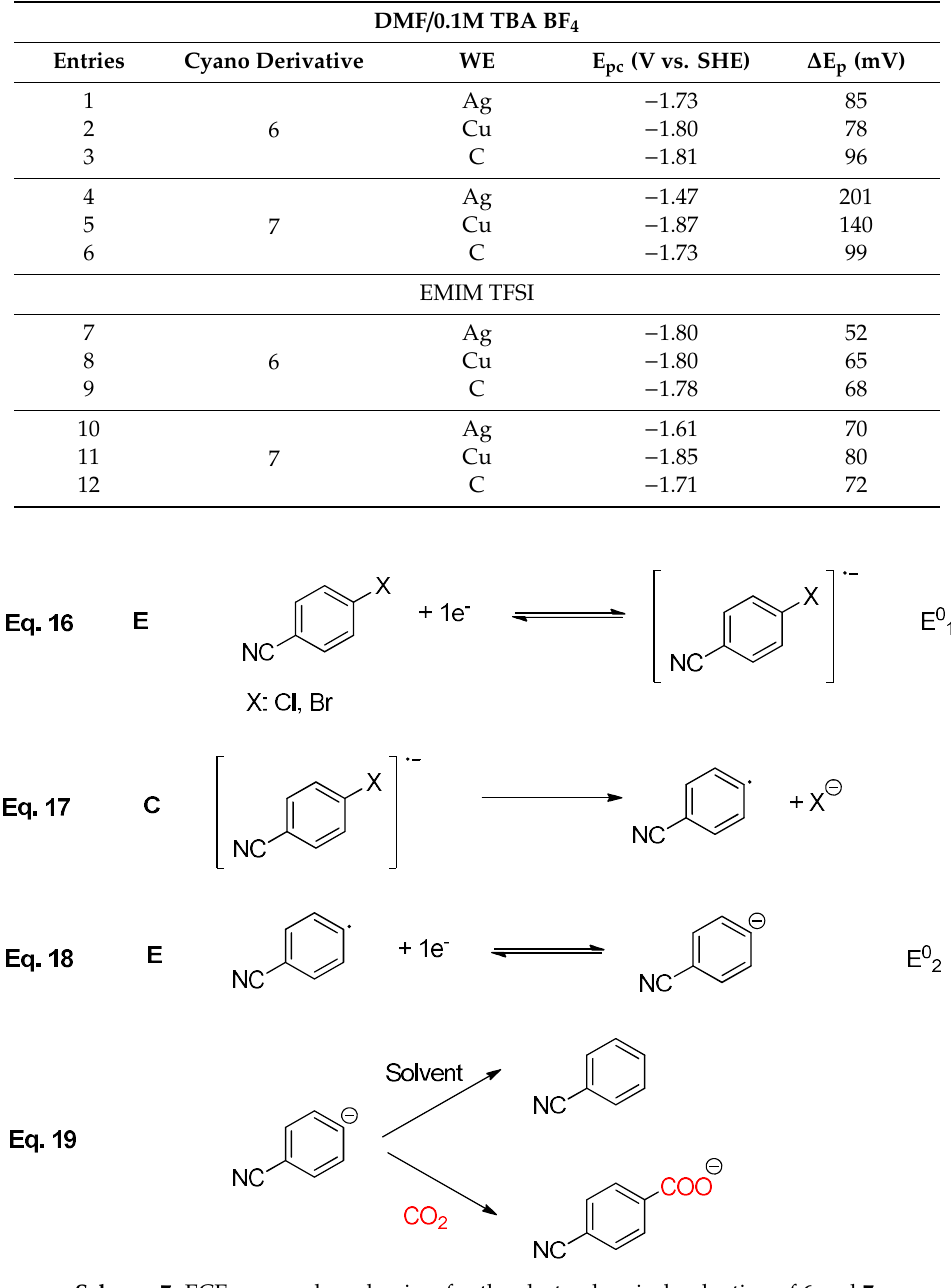
Table 4. Electrochemical parameters for electroreduction of compounds 6 and 7 in DMF / 0.1M TBA BF 4 and EMIM